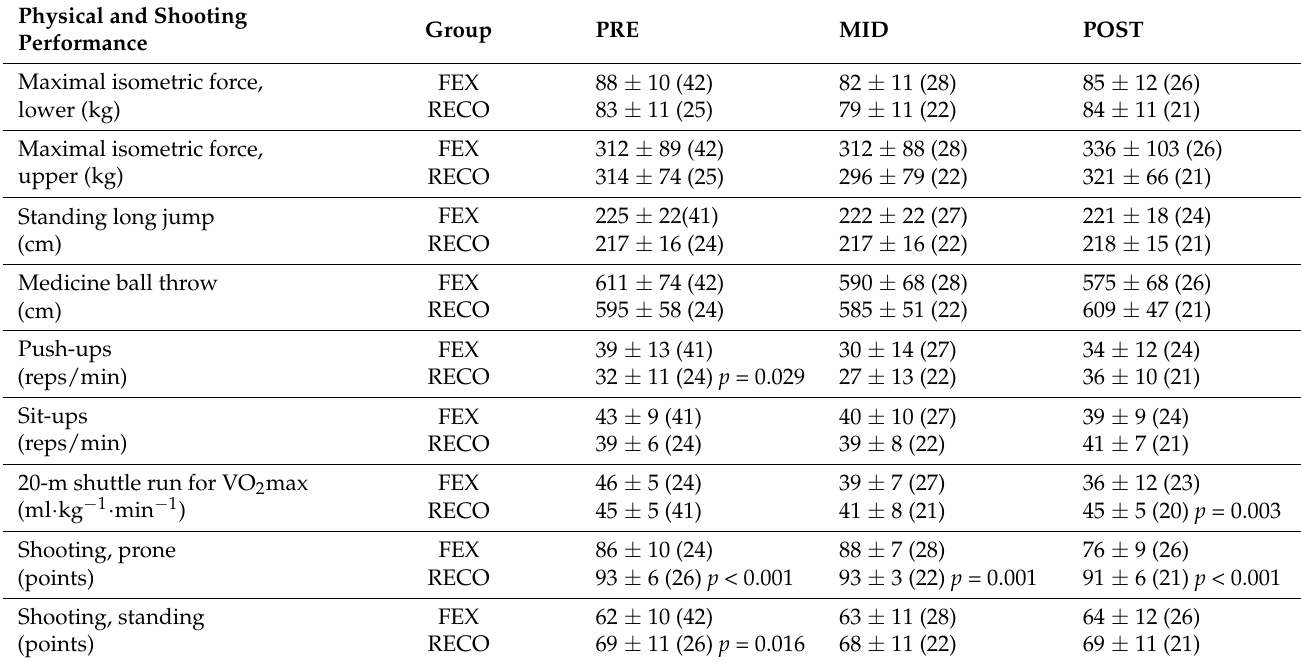
Table 3. Mean ( ± SD) physical fitness tests and shooting performance results during the training in the field exercise (FEX) and recovery (RECO) groups. Statistical significances are presented between the groups. Number of participants are shown in brackets. VO 2 max refers to maximal oxygen uptake.